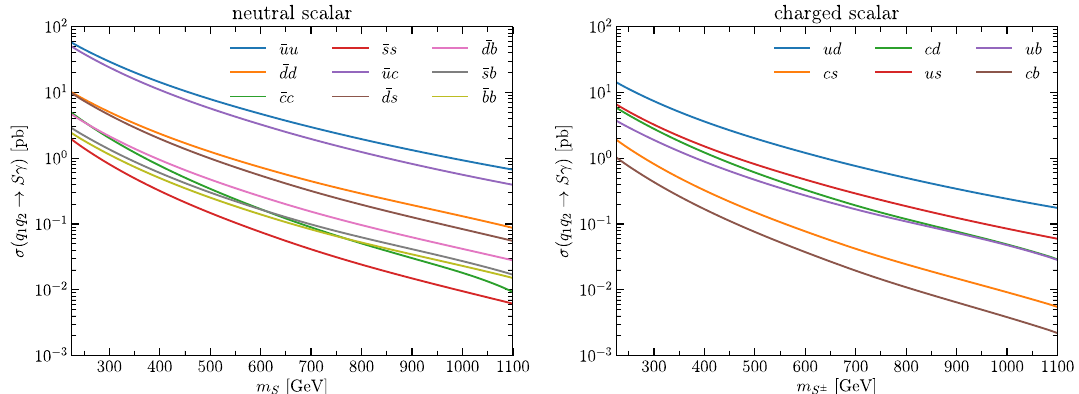
Fig. 2 Cross section of quark-initiated scalar production in association with a photon. Left: Neutral scalar. Right: Charged scalar (summing the positive and negative charged scalar cross sections) Table 3 Cuts applied after trigger selection